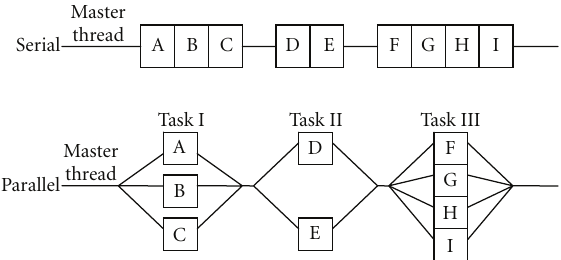
Figure 1: Comparison of entire progress between serial and parallel